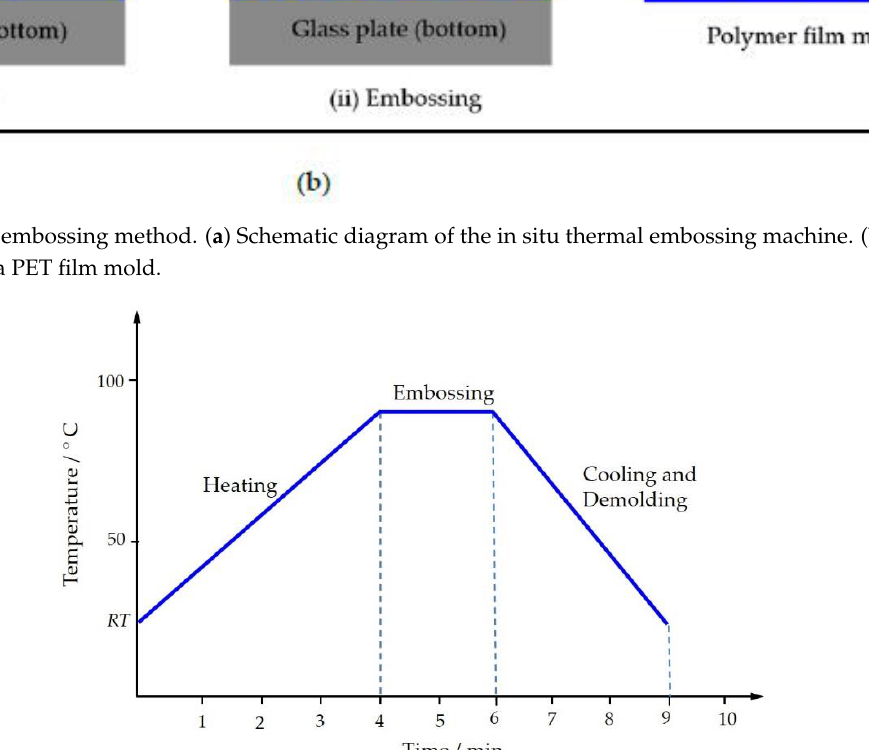
Figure 3. Processing curve of the thermal embossing process to fabricate a PET film mold.